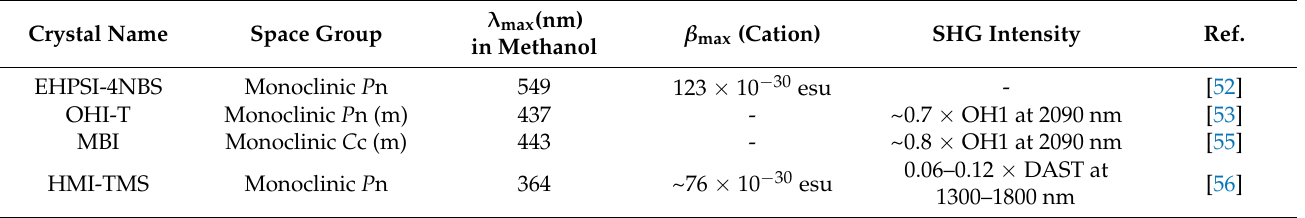
Table 4. Comparison of the mentioned indolium-based, benzoindolium-based, and benzimidazolium- based THz crystals.